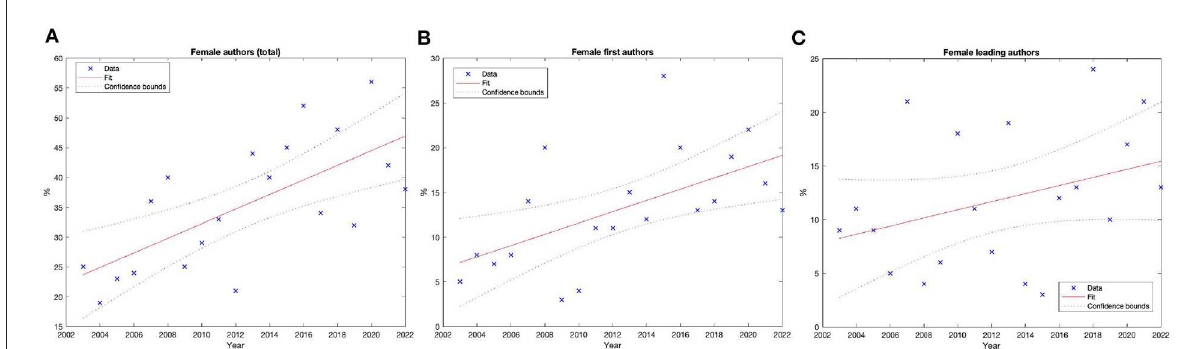
FIGURE3 Linear regression fits for percentages of (A) female authors ( R 2 = 0.46, p = 0.00), (B) female first authors ( R 2 = 0.33, p = 0.007), and (C) female leading authors ( R 2 = 0.125, p = 0.126) out of total number of accepted